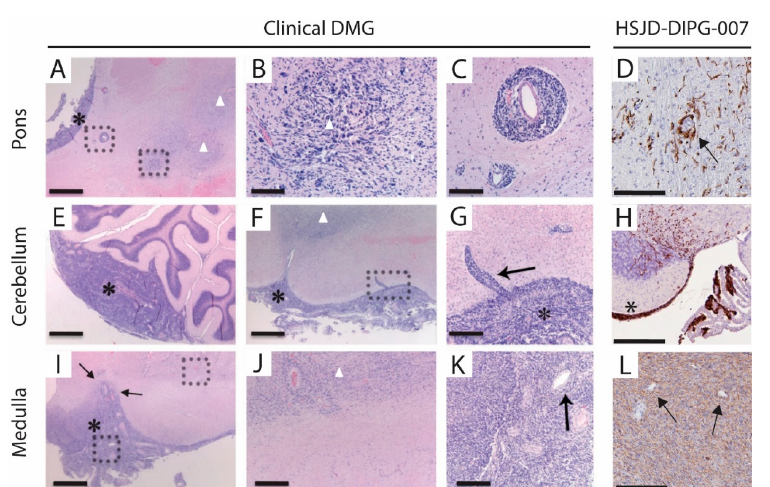
Figure 6. Comparative assessment of clinical DMG and HSJD-DIPG-007 PDX model histopathology. The comparative clinical DMG panel (panes A – C , E – G , I – K ) was adapted and reproduced with per- mission from Caretti et al. [53]. ( A , E , F , I ) H & E staining of clinical DMG at the pons, cerebellum, and medulla. ( B , C , G , J , K ) Magnifications of H & E staining indicated by the dotted squares. ( D , H , L ) Antihuman vimentin staining of HSJD-DIPG-007 PDX model at the pons, cerebellum, and medulla. ( A , E – I ) Asterisks indicate leptomeningeal growth. ( D , G ) Arrows indicate perivascular growth, and ( I , K , L ) represent blood vessels in dense tumour areas. Scale bars = 250 µm ( A , F , I ), 62.5 µm ( B , C , G ), 125 µm ( J , K ), 500 µm ( E ), and 50 µm ( D , H , L ).